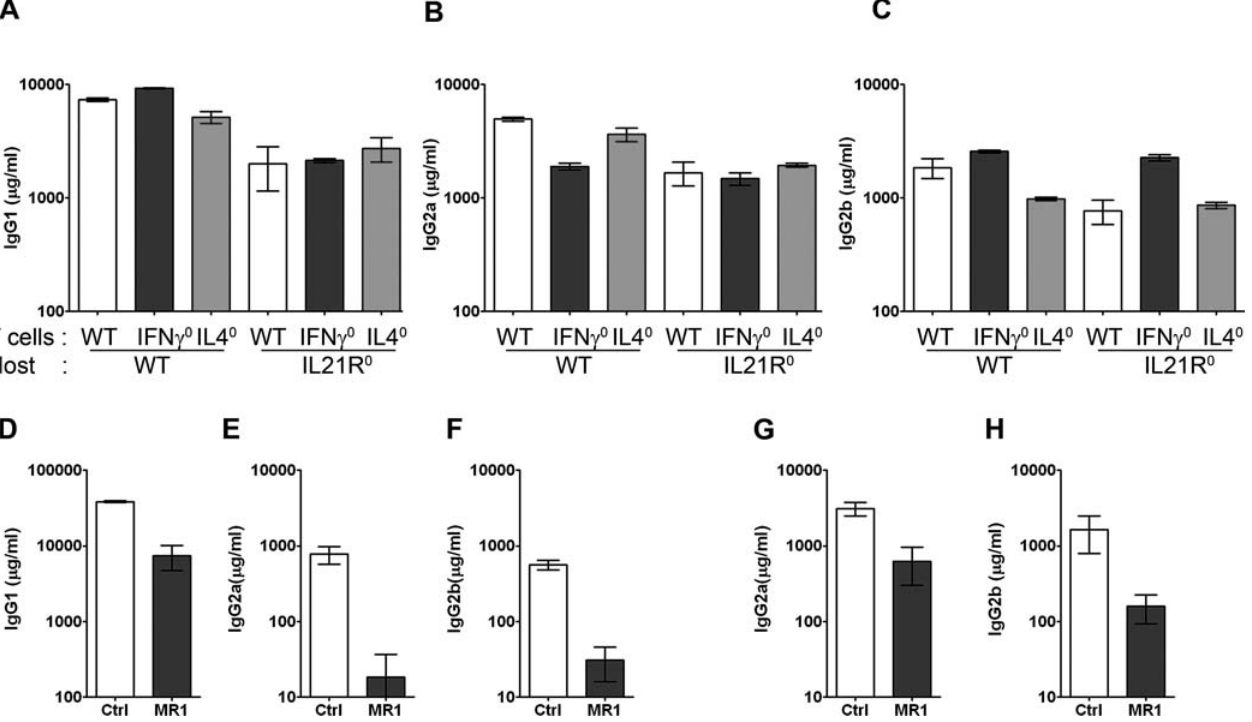
Figure 5. Cytokine and CD40L Dependence of Help Rendered by Adaptively Tolerant T Cells (A–C) Serum from mice that received T cells 8 d before were assayed for total immunoglobulins as described. T cells were from 5C.C7 TCR transgenic mice (white bars) or similar mice also deficient in IFN- c (black bars) or IL-4 (gray bars). Host mice were mPCC,CD3 e (cid:1) / (cid:1) (left three bars in each graph) or IL- 21 receptor–deficient mPCC,CD3 e (cid:1) / (cid:1) mice (right three bars). (D–F) B cells were infused into mPCC,Rag2 (cid:1) / (cid:1) mice that harbored stably adapted 5C.C7 T cells. The blocking anti-CD40L antibody MR1 (black bars) or a control hamster antibody (white bars) was administered at the same time and on every other subsequent day for 13 d, before assaying serum for antibody titers. (G, H) Similar experiments (as in D–F) were carried out, but the blocking antibody treatment was terminated at 6 d. Twenty-two days afterward, serum IgG2a (G) and IgG2b (H) levels were measured in the MR1 treated (black bars) or control (white bars) mice. DOI: